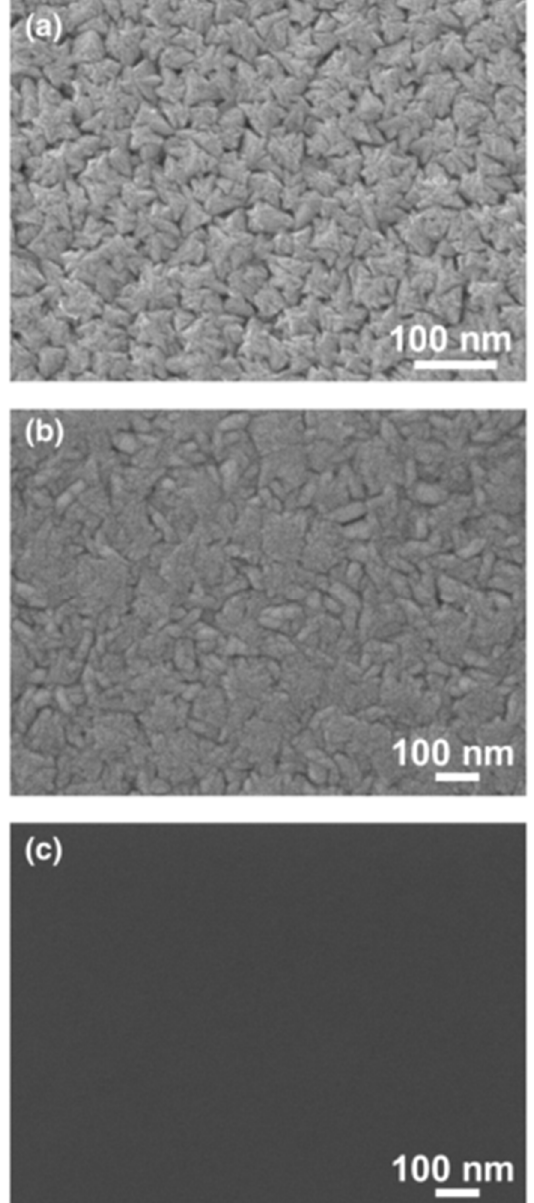
Figure 3. Plane-view SEM micrographs of (Al 1.5 CrNb 0.5 Si 0.5 Ti)N x coatings deposited at substrate bias of ( a ) 0 V; ( b ) −50 V and ( c ) −150 V .Reprinted with permission from [53]. 2012, Elsevier.